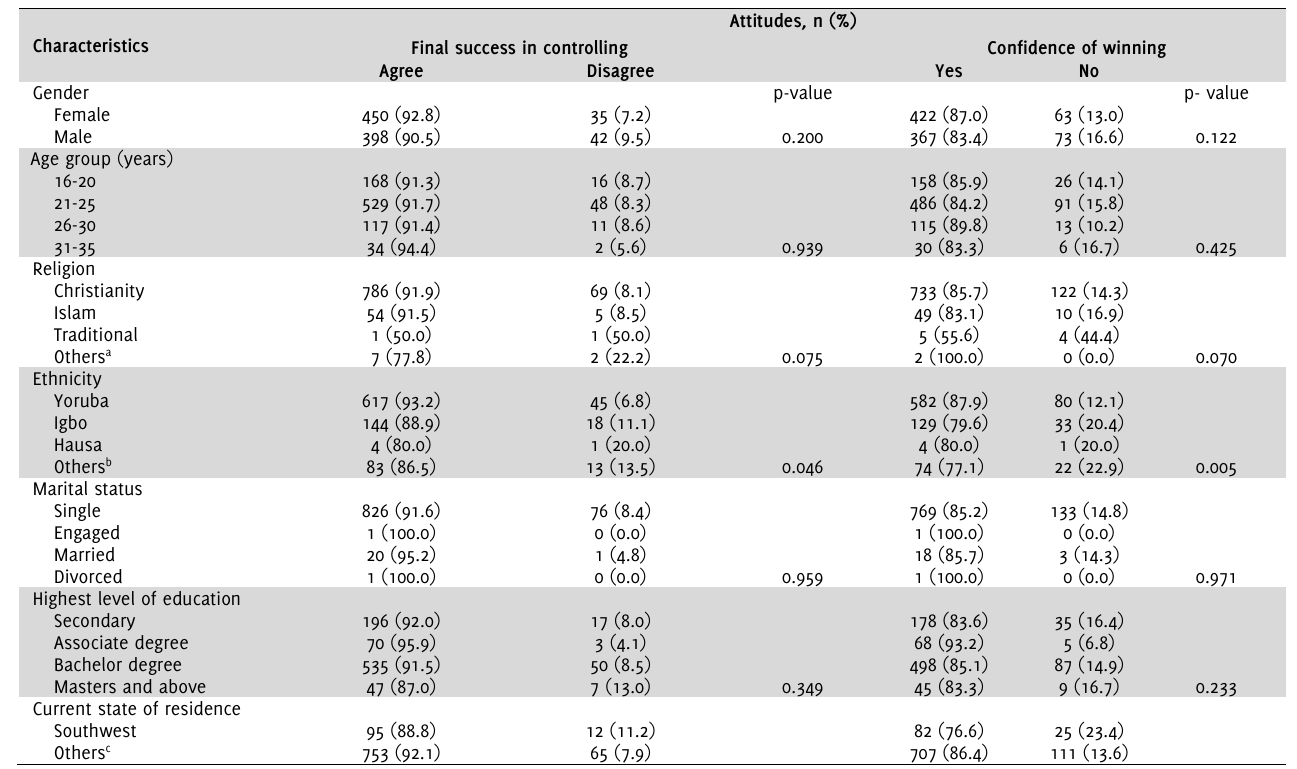
Table 3 . Attitudes Towards COVID-19 by Demographic Variables.